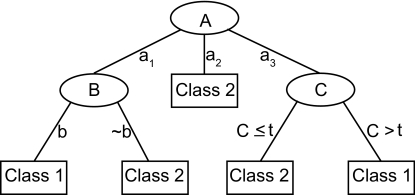
A decision tree.